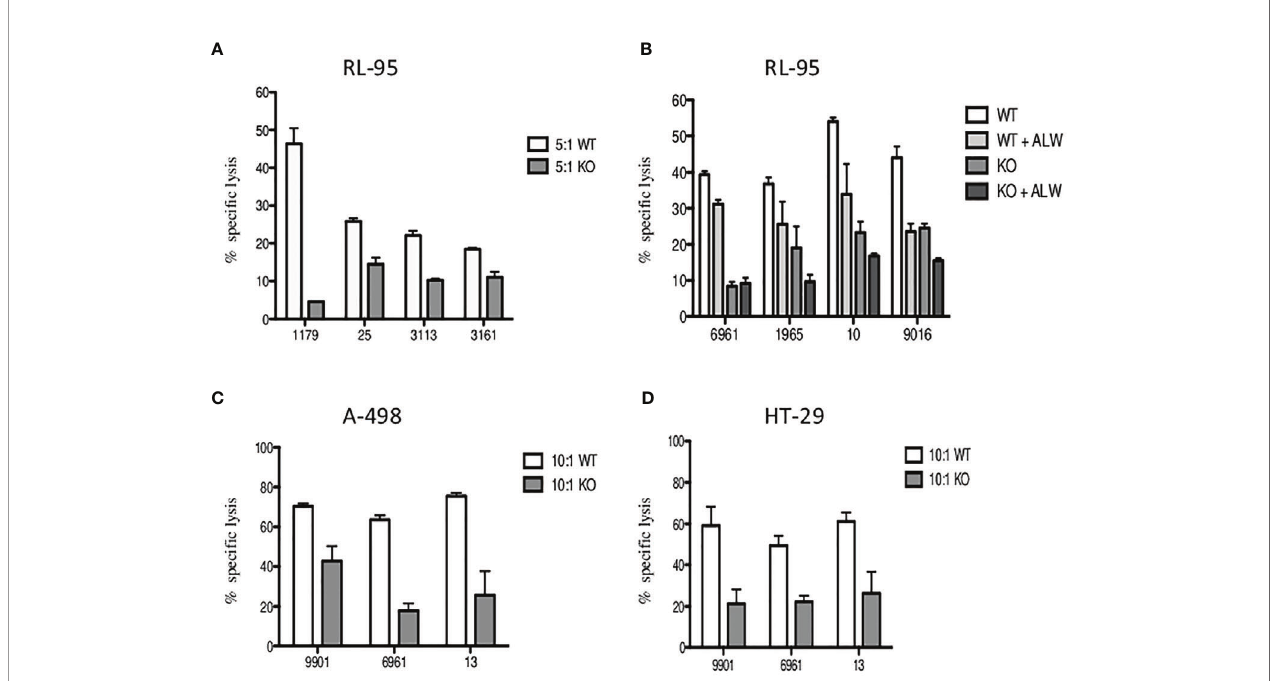
FIGURE 7 | The inhibition of speci fi c lysis of EphA2-positive RL-95 endometrial cell line. (A) Freshly sorted V d 1 T cells were co-cultured with tumor targets for 4 h, and cytotoxicity was determined at 5:1 E:T ratio for the wild type (WT, white bars) and the EPHA2 knockout (KO, grey bars) shown as the mean ± SD of independent experiments performed in duplicates (HD numbered anonymously). (B) Similarly, inhibition of speci fi c lysis by V d 1 T cells was determined at 10:1 E:T ratio for the wild type (WT, white bars) and the EPHA2 knockout (KO, dark grey bars) with/without the presence of small-molecule inhibitor ALW-II-41-27 (1uM) and is shown as the mean ± SD of independent experiments performed in duplicates. (C) The EPHA2 knockouts of renal tumor cell line A-498 (grey bars) and colon adenocarcinoma tumor cell line HT-29 (D) were generated and speci fi c lysis was compared with WT cells (white bars) at 10:1 ratio. Signi fi cant inhibition of cell lysis mediated by tumor-reactive V d 1 T cells was shown as the mean ± SD of independent experiments performed in